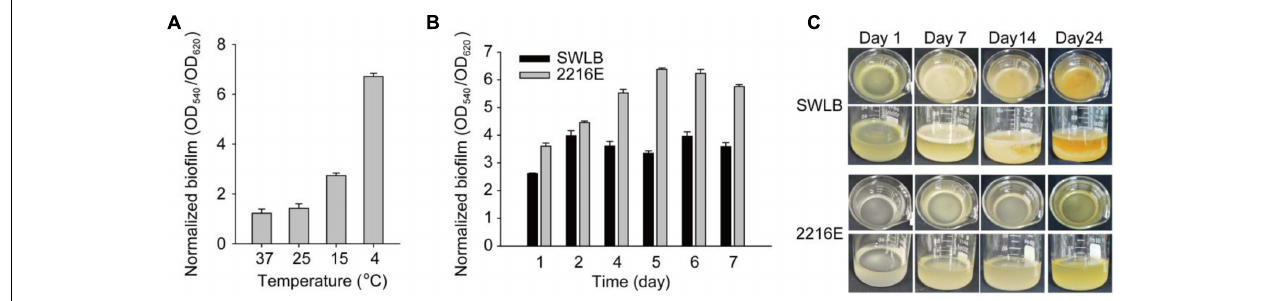
FIGURE 1 | SM9913 forms attached biofilm and pellicle. (A) Attached biofilm formation of SM9913 cultured at different temperatures for 24 h in SWLB medium. (B) Attached biofilm formation of SM9913 cultured in SWLB and 2216E at 15 ◦ C. Data represent the average of 15 replicate wells from three independent cultures, and one standard deviation is shown in both (A,B) . (C) Pellicle formation of SM9913 cultured without shaking in SWLB and 2216E at 15 ◦ C. Three independent cultures were tested and one representative image is